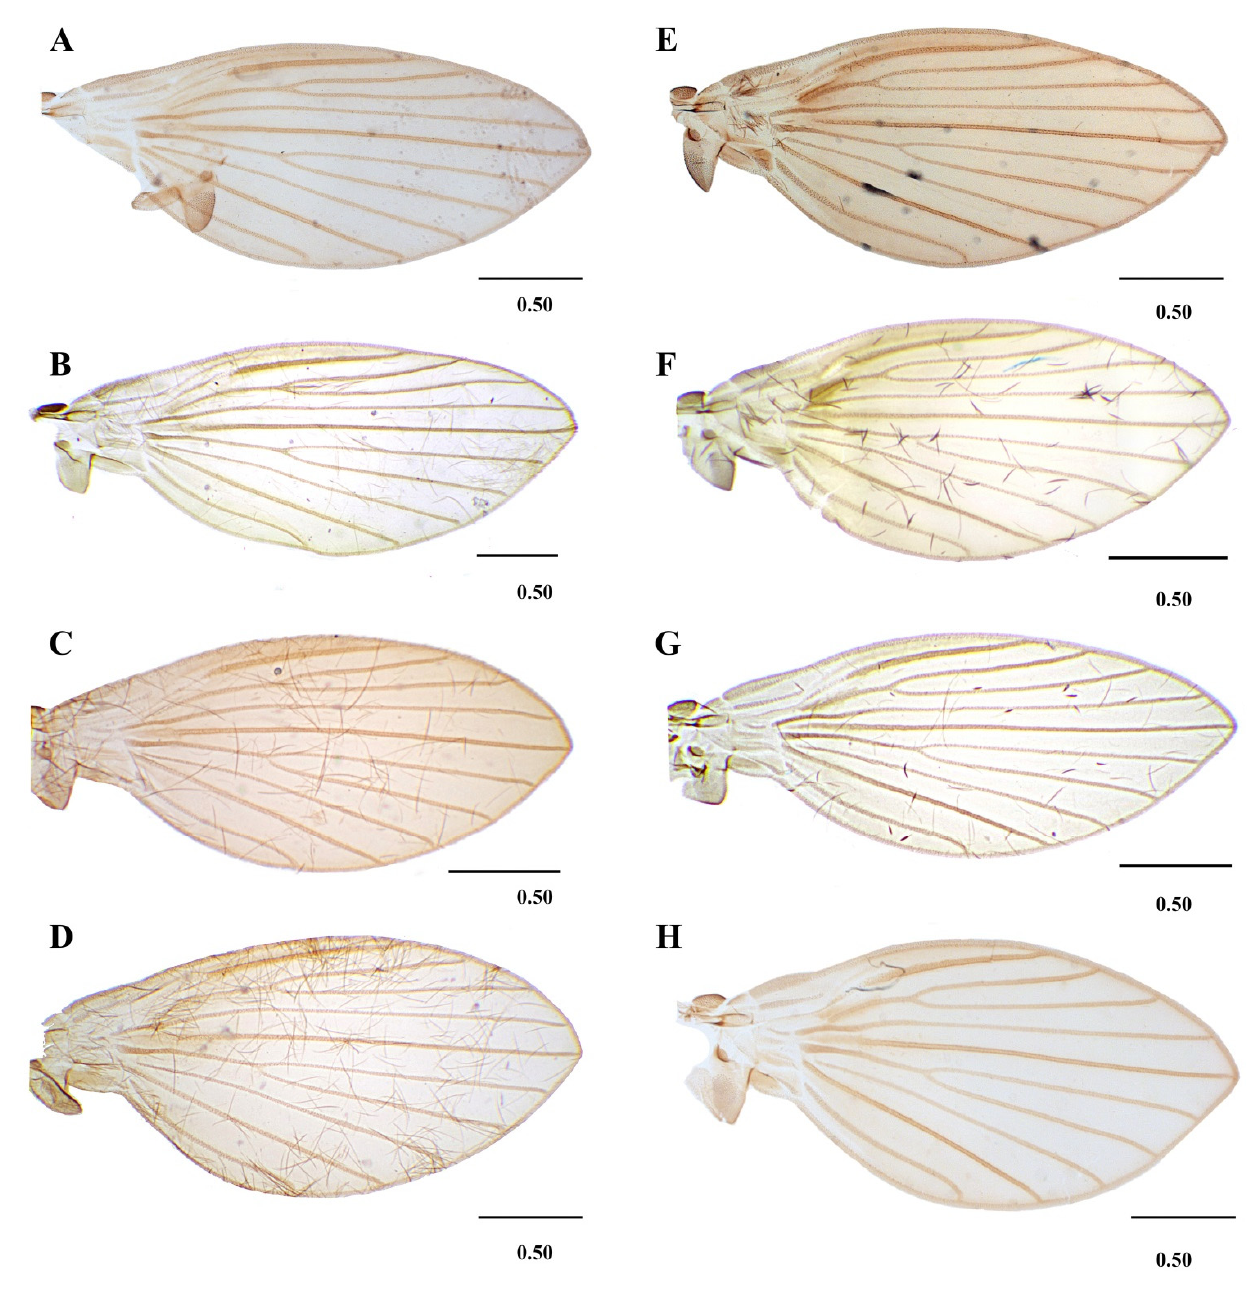
Figure 8. Wings variability of: ( A – D ) Lepiseodina latipennis (Sarà 1953). ( E , F ) L. tristis (Meigen, 1830), ( G , H ) L. rothschildi (Eaton, 1912). Scale ( A – H ) in millimeters (mm). 5. Aedeagus asymmetrical, with ejaculatory apodeme broader than distal elements (Figures 3C, 4D, 5C, 6B and 7C); ascoids digitiform or S-shaped . . . Lepiseodina Enderlein, 1936 - Aedeagus symmetrical, with ejaculatory apodeme narrower than distal elements (Figures 12C and 13C); ascoids leaf-shaped or digitiform . . . Telmatoscopus Eaton,